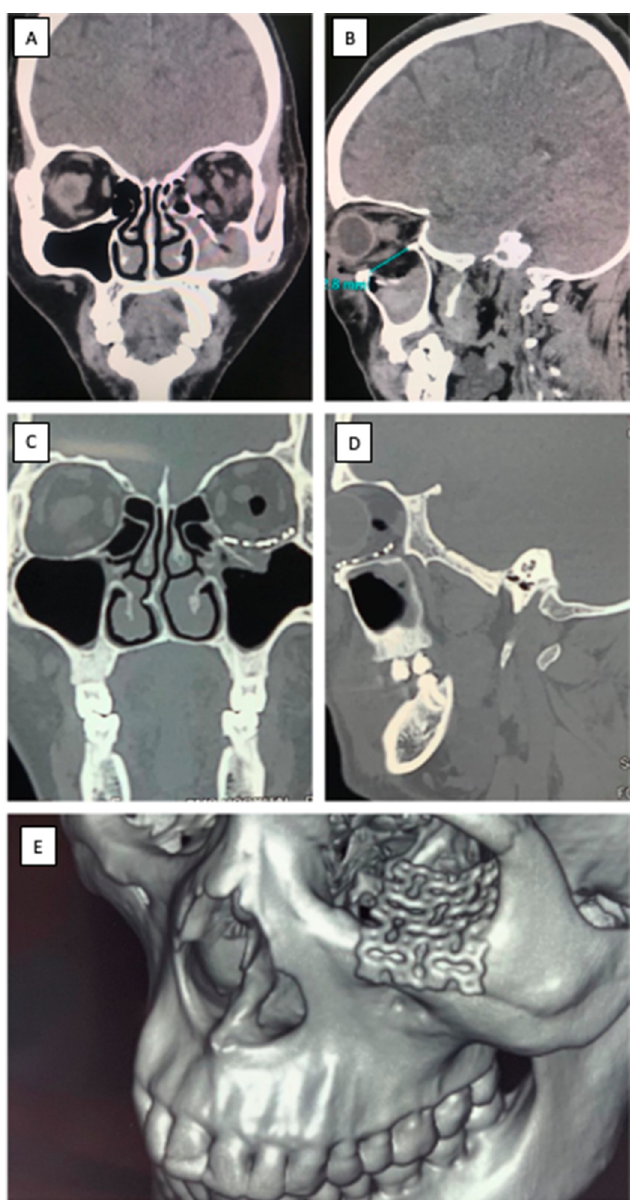
Fig. 3. (A) Preoperative coronal and (B) sagittal scan showing the orbital fl oor defect which was reconstructed with a cut and shaped titanium mesh and adapted to the orbital fl oor. Post-operative coronal and sagittal (C and D) view showing the mesh spanning the defect. 3D reformatted image of the orbital defect being spanned by the titanium mesh